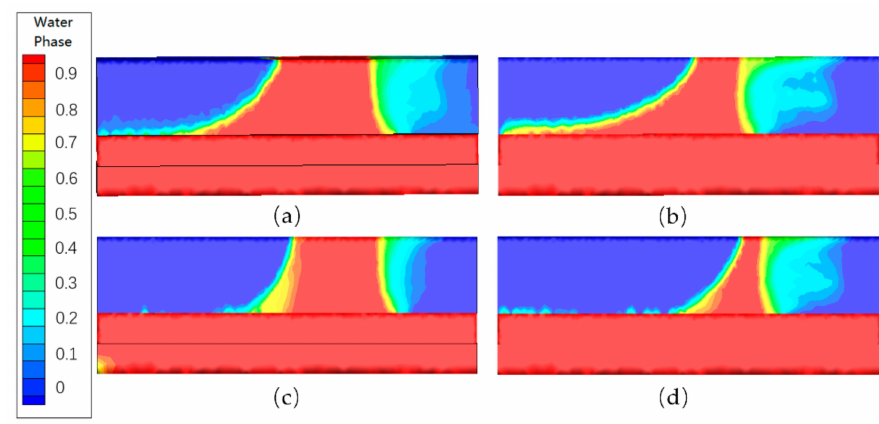
Figure 8. Distribution of water phase: ( a ) both microdroplet and culture solution flow velocities are 0.05 m/s; ( b ) microdroplet and culture solution flow velocities are 0.1 m/s; ( c ) the relative velocity of microdroplet to culture solution is 0.03 m/s when culture solution velocity is 0.01 m/s; ( d ) the relative velocity of microdroplet to culture solution is 0.09 m/s when culture solution velocity is 0.01 m/s.